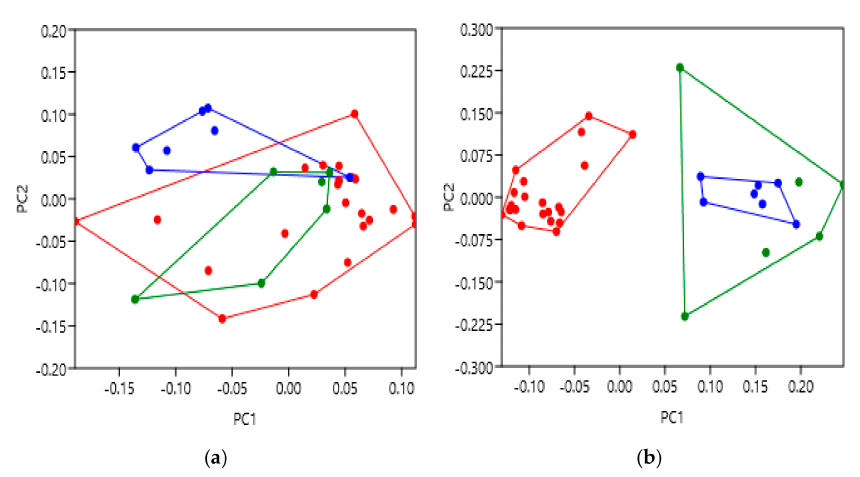
Figure 3. Principal component analysis to show the β 2-adrenergic receptor ( β 2AR) shape variation between activation states. Inactive structures are red, active are blue and active with G s coupled are green. ( a ) PC score comparison for the extracellular face of the β 2AR transmembrane bundle. ( b ) PC score comparison for the intracellular face of the β 2AR transmembrane bundle. The supporting statistical data are summarised in Tables 2 and 3. Additional supporting figures are found in Appendix B Figure A1. Table 2. A summary of ANOSIM (clustering) test data for the extra- and intracellular faces of the β 2AR receptors, to support Figure 3; 9999 permutations performed on PC1-5, significant p values (<0.05) are shown in bold.